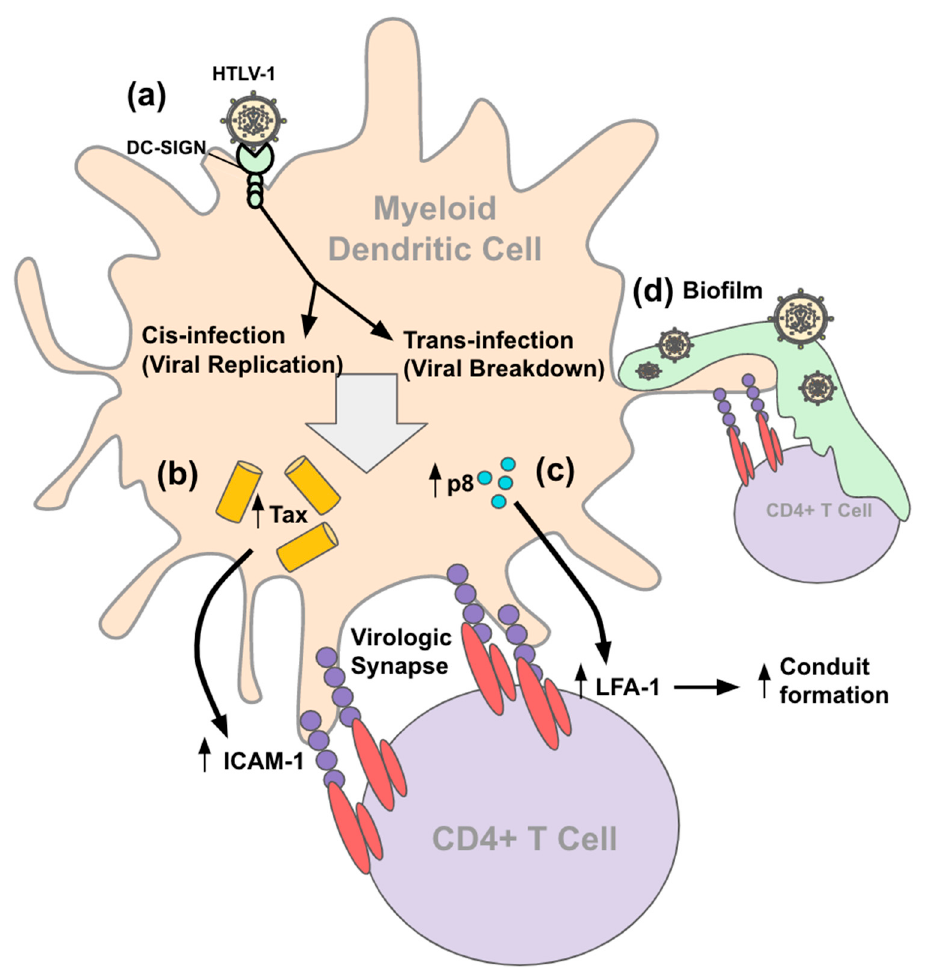
Figure 2. HTLV-1 interaction with DC. ( a ) HTLV-1 binds DC-SIGN, Glut-1, NRP-1, and/or HSPG receptor on DC cell surface. DC-SIGN is the most important receptor on DCs. HTLV-1 then enters the DC and undergoes viral replication to infect the DC in a process called cis-infection. Alternatively, HTLV-1 enters the DC and undergoes viral breakdown to be processed and presented on MHC surface receptors (not pictured) in a process called trans-infection. DCs spread HTLV-1 infection to CD4 + T cells through the formation of virological synapses, conduit formation, and viral biofilms. ( b ) HTLV-1 Tax protein accumulates in the DC and induces increased ICAM-1 expression on the surface of the DCs. Increased ICAM-1 allows for more efficient binding to CD4 + T cells via LFA- 1 interaction. ICAM-1/LFA-1 interaction allows for the formation of virological synapses where HTLV-1 components are exocytosed to and concentrated within to increase exposure of T cells to viral particles for infection. ( c ) HTLV-1 p8 protein also builds up within the DC and induces increased LFA-1 protein expression on T cells. Increased LFA-1 expression functionally allows for conduit formation between DCs and T cells to allow for the spread of infection over greater distances versus neighboring cells. ( d ) Viral biofilms form on the surface of the DC and act as reservoirs for viral growth to allow the spread to neighboring CD4 + T cells.